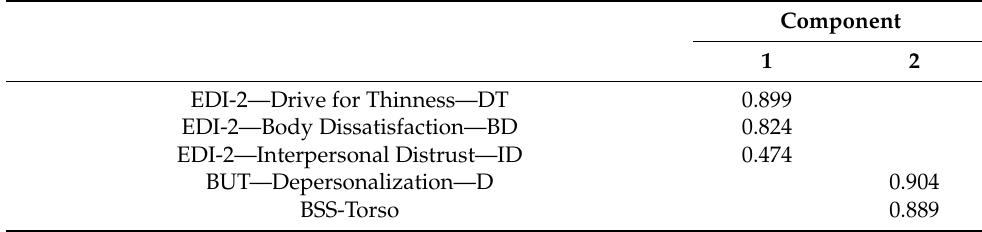
Table 5. Principal component